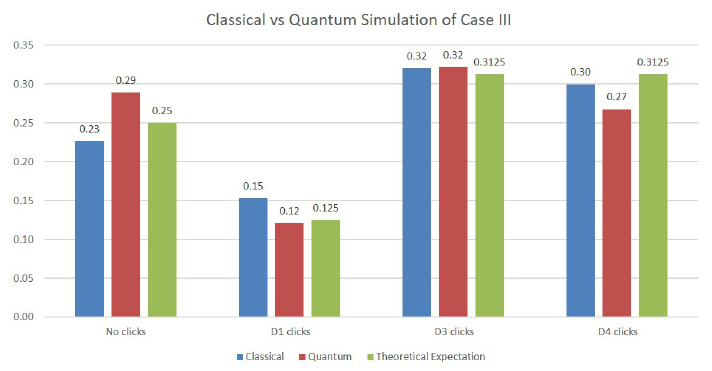
Figure 6. Simulations results for Case